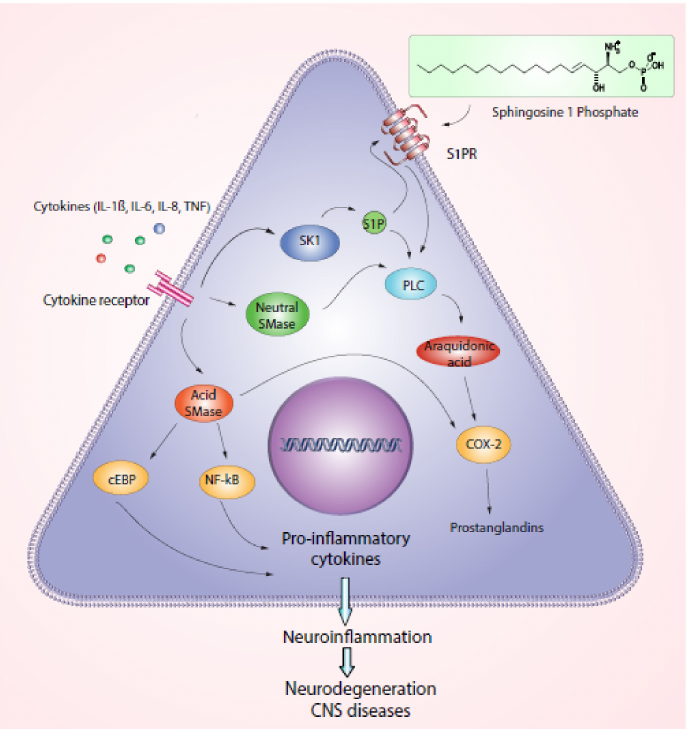
Figure 1. Mechanism of neuroinflammation associated with sphingolipids. Oligodendrocyte. Sphin- golipids as sphingosine 1 phosphate cause the transduction of the PLC pathway with the ongoing activation of the araquidonic acid pathway. Araquinodate induces the activation of COX-2-producing prostaglandins that act as inflammatory mediators. Enzymes such as Acid sphingomyelinase SMase and Neutral sphingomyelinase are also capable of active araquidonic, and COX-2 paths. Interest- ingly, extracellular inflammatory mediators, including cytokines (IL-6, IL-1 β , IL-8, and TNF α ) may activate sphingomyelinase enzymes, mainly, acid sphingomyelinase with the subsequent activation of cEBP and NF-kB trans-activators that lead the production of pro-inflammatory cytokines. The inflammatory mediators and pro-inflammatory cytokines are associated with the development of neuroinflammation, demyelination, and degenerative